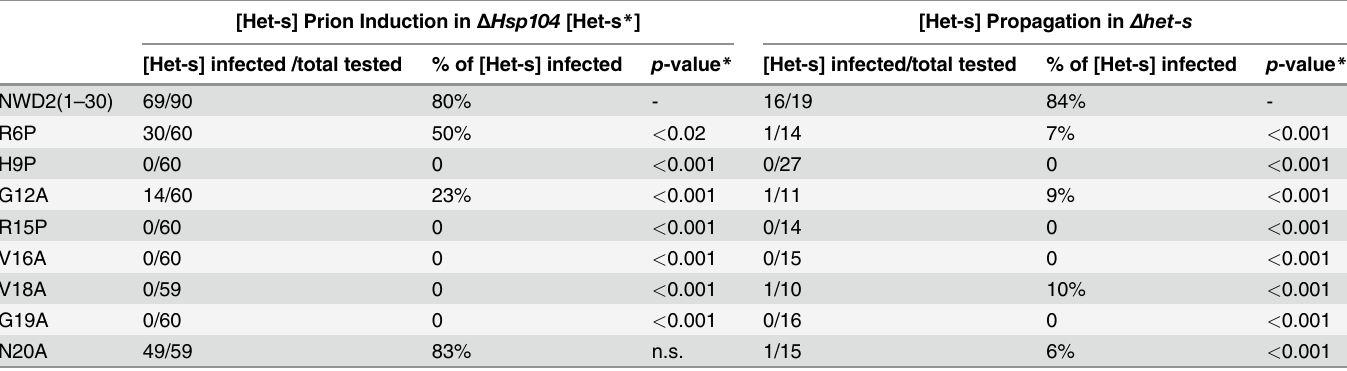
Table 1. Prion-inducing and prion propagation ability of wild-type and mutant NWD2(1 –